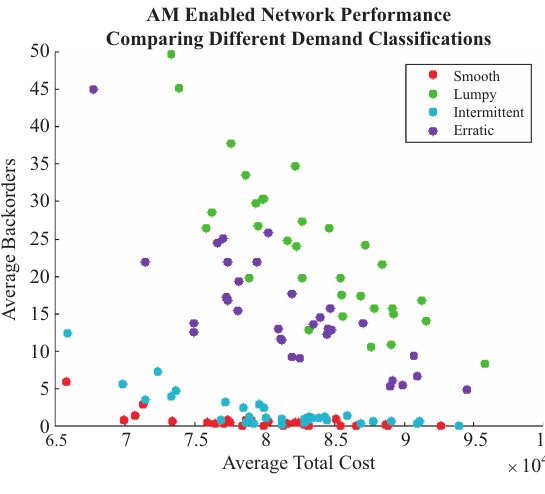
Figure 8. (Color online) Average network performance organized by underlying classification of